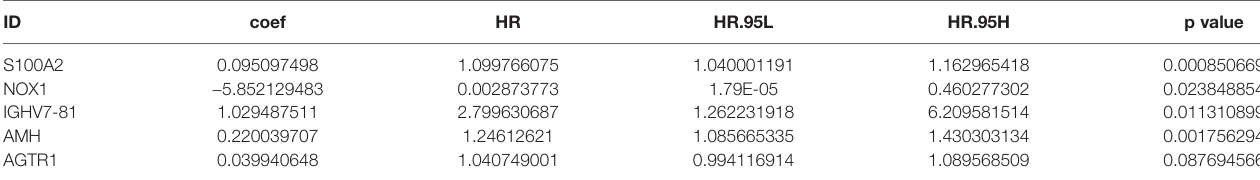
TABLE 4 | Multivariate Cox regression analysis to fi ltrate key ARGs for BC